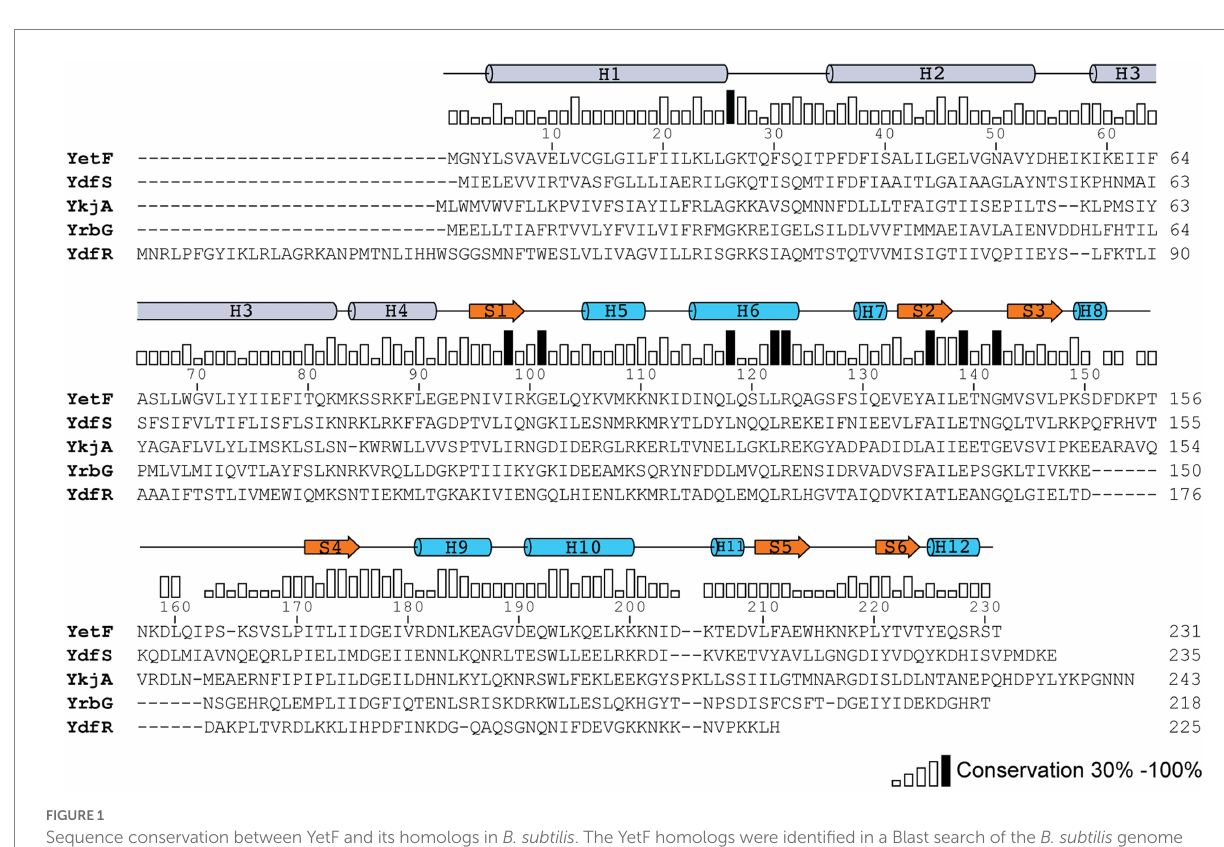
FIGURE 1 Sequence conservation between YetF and its homologs in B. subtilis . The YetF homologs were identified in a Blast search of the B. subtilis genome against the YetF sequence. Sequence conservation is shown as a bar graph, with black bars indicating identity among five proteins. Secondary- structure assignments of YetF from the crystal structure (PDB ID: 3C6F) are shown as blue cylinders (helices) and orange arrows ( β strands). Predicted secondary-structure elements by AlphaFold for the N-terminal TM region are shown as gray cylinders ( α